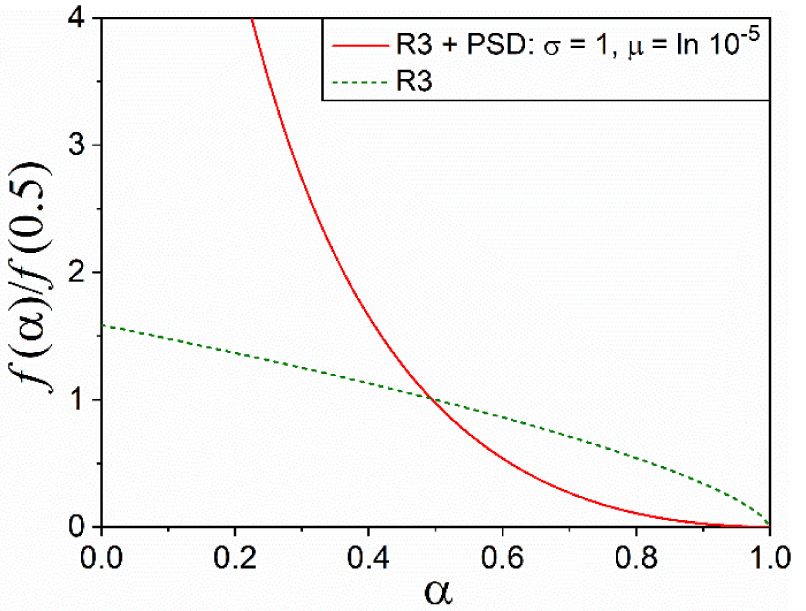
Figure 2. Normalized kinetic models. The dashed green line represents the ideal model R3, whilst the continuous red line corresponds to the kinetic model obtained when PSD is taken into